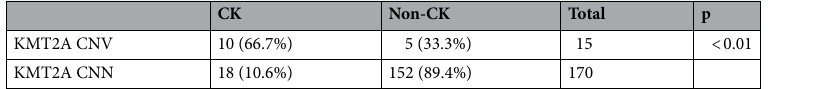
Table 4. The results of KMT2A copy number and complex karyotype in AML. KMT2A CNV KMT2A copy number variation, KMT2A CNN normal KMT2A copy number, CK complex